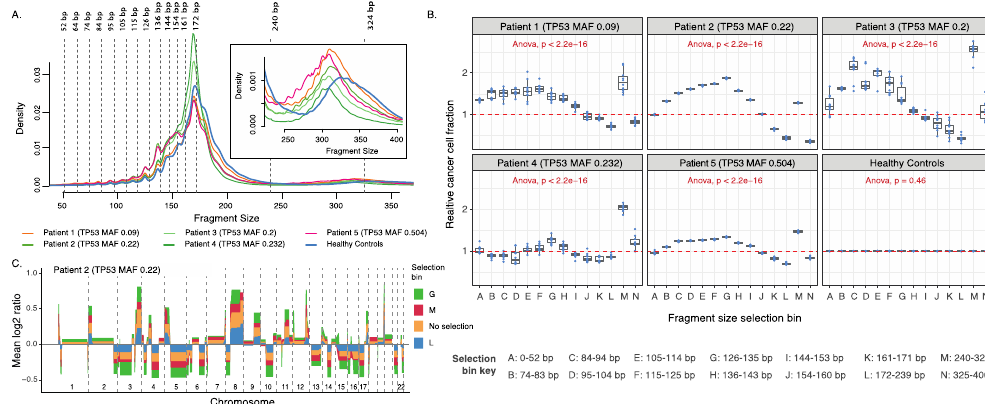
Figure 2. Fragment size analysis. ( A ) Fragment size distribution of 5 HGSOC patients and panel of healthy controls. The vertical dashed lines are placed on the fragment sizes between 52 and 172 bp where 10 bp periodicity is observed. The vertical lines at 240 and 324 bp show the range at which a shift in the di-nucleosomal peak occurs between HGSOC patients and healthy controls. The inset plot enlarges the density profile in the di-nucleosomal fragment length range. ( B ) Copy number aberration analysis of all technical replicates comprising of different fragment length ranges as indicated by figure legend. The cancer cell fraction (CCF) was measured for each dataset with and without fragment selection. The relative CCF on the y-axis is the ratio of these two estimates. Above each plot, the TP53 MAF, as determined by TAm-Seq is shown for each patient ( C ) The average relative copy number values from the 10 replicates of patient 2. The different colors indicate different size selection ranges as well as no size selection. Corresponding data from the other patients are shown in supplementary Fig.